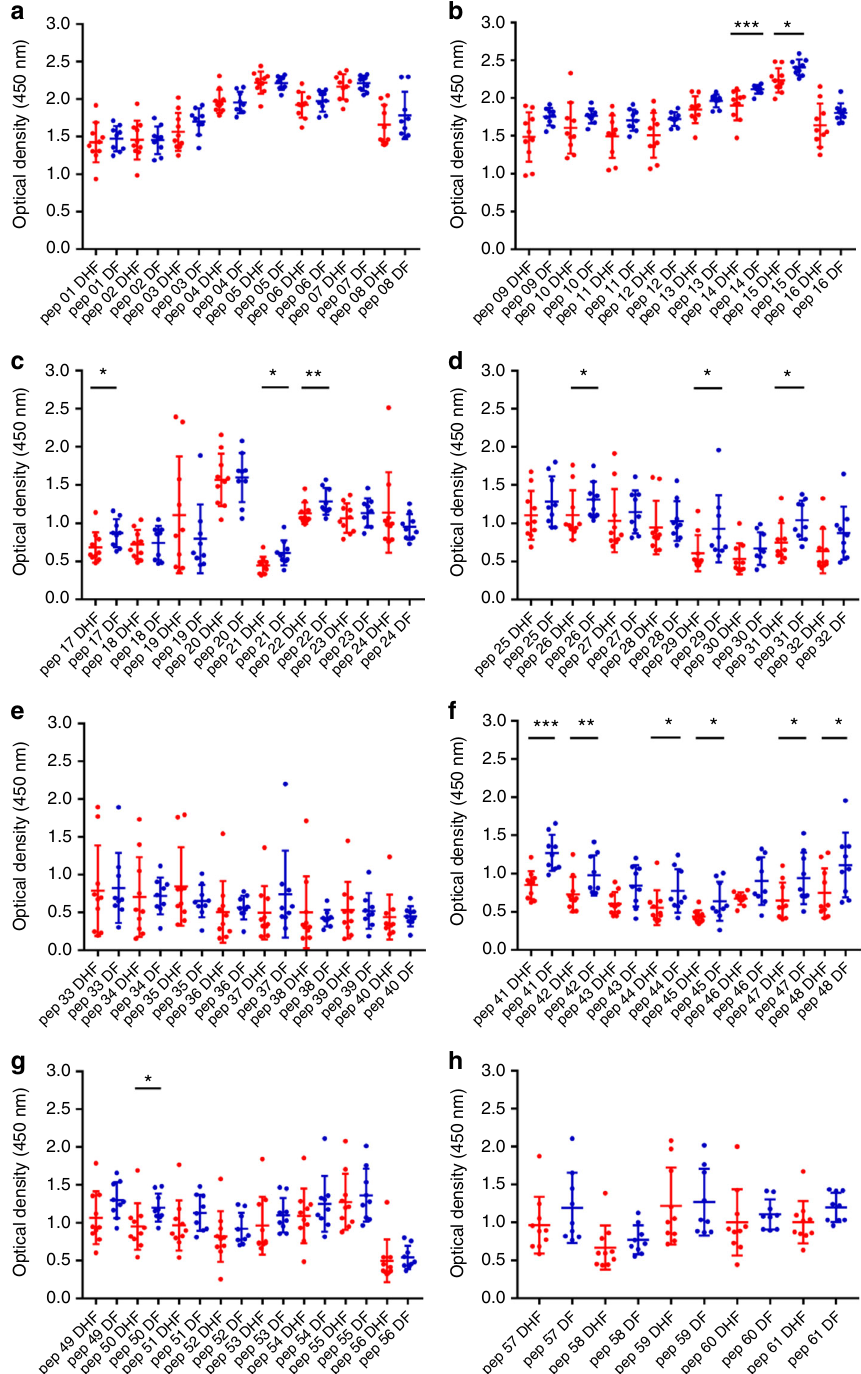
Fig. 5 DENV1 NS1 antibody responses to NS1 peptides in the critical phase. a – h DENV1 NS1-speci fi c IgG antibody responses to 61 DENV1 NS1 overlapping peptides in patients with DF ( n = 10) and DHF ( n = 10) were measured by ELISA on day 7 of illness. Differences in mean values between antibody responses to overlapping peptides in patients with DF and DHF were compared using the Mann – Whitney U test (two tailed). NS1 antibody levels in patients with DHF are indicated in red, and in those with DF in blue. Error bars indicate mean and standard deviation (SD). * P < 0.05, ** P < 0.01, *** P <